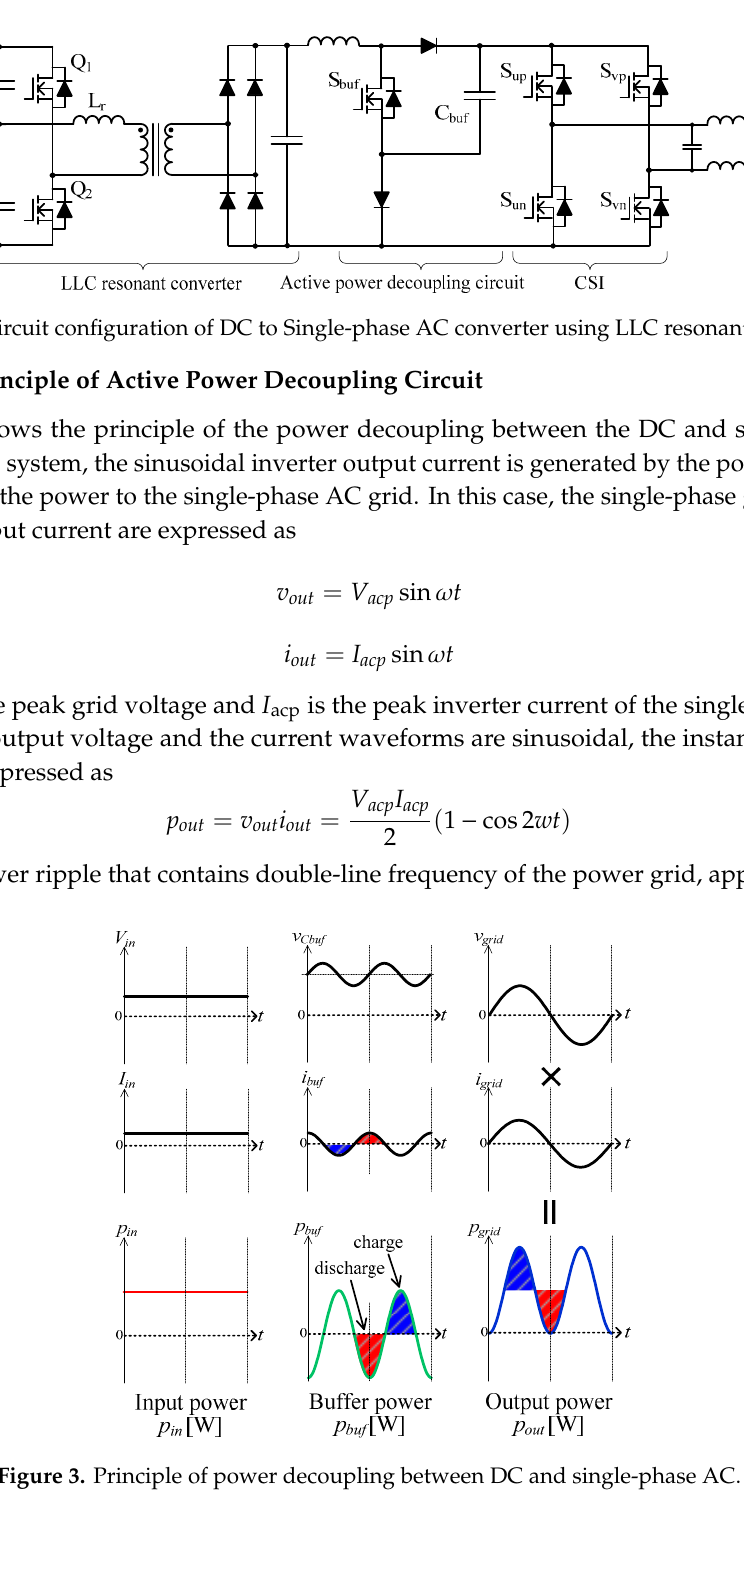
Figure 1. Configuration of PV power generative system. ( a ) Centralized inverter and ( b ) micro- inverter.